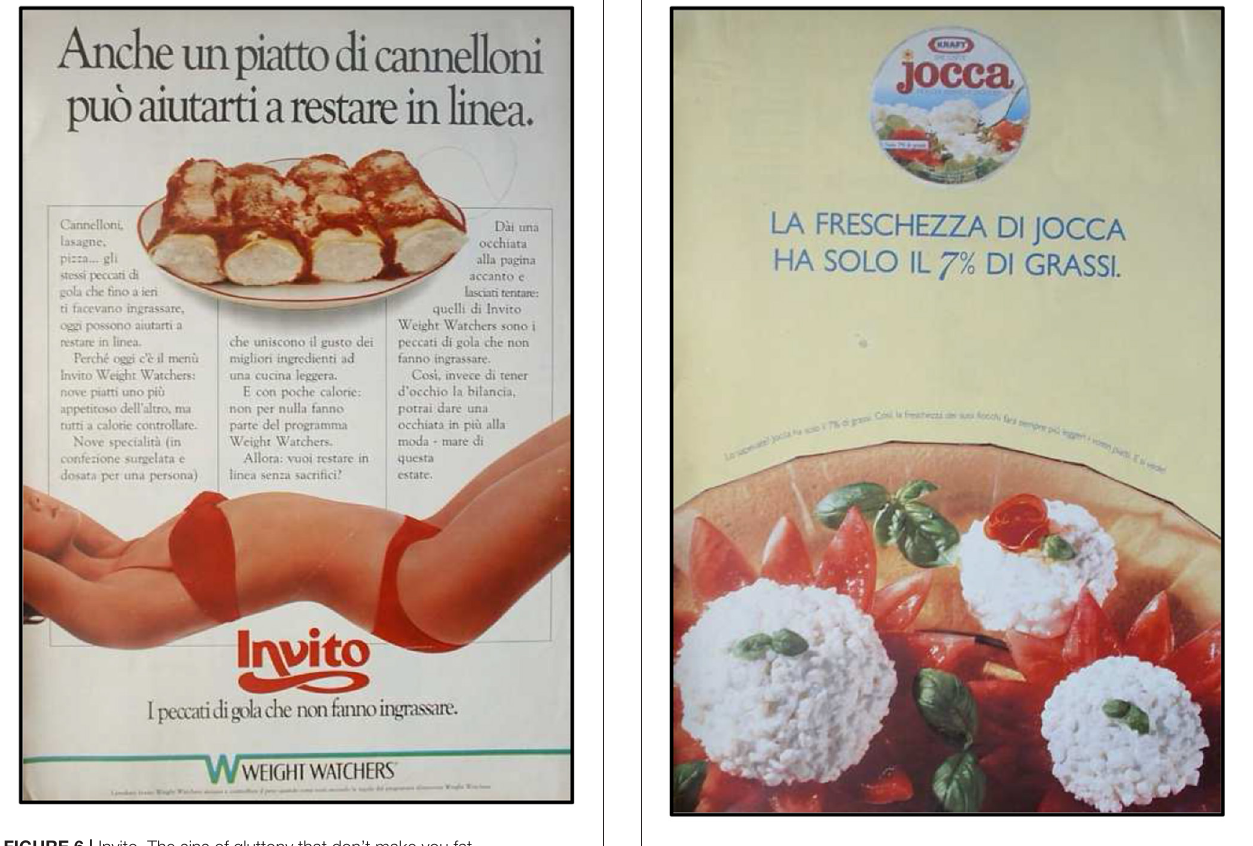
nineteen-eighties advertising of dietetic products in Italy definite